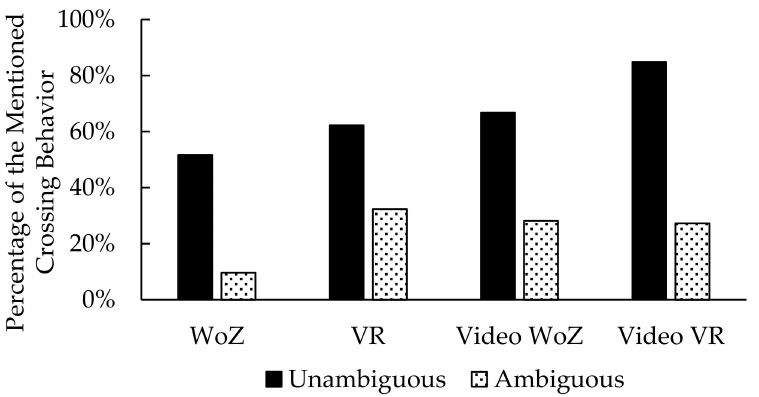
Figure 6. Mentioned crossing behavior for the intention Let the HRU go first , for the participants who understood the intention correctly.